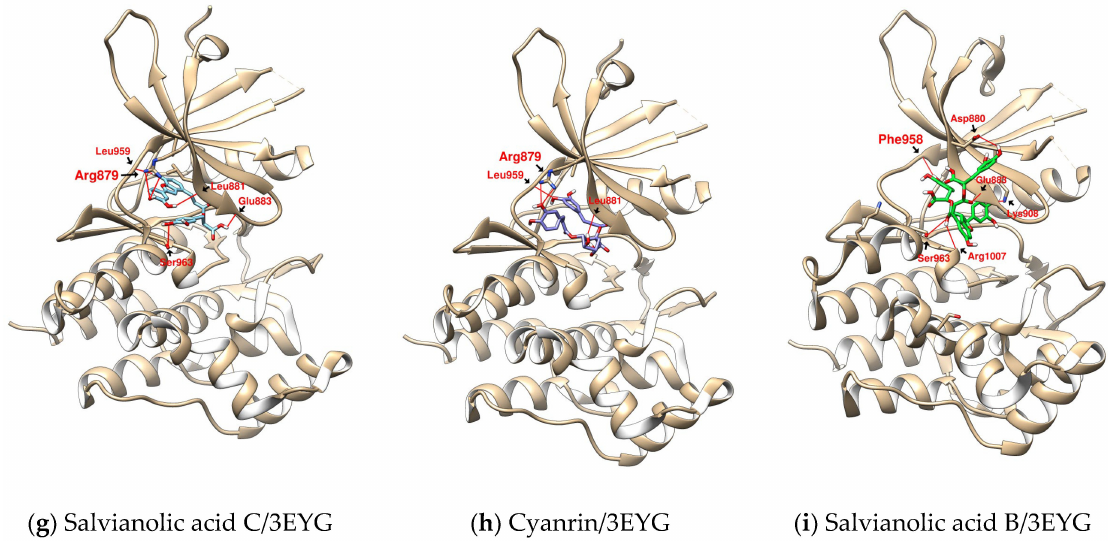
Figure 4. The lowest-energy configurations of six phenolic acids docked to JAKs: ( a – f ) docking to